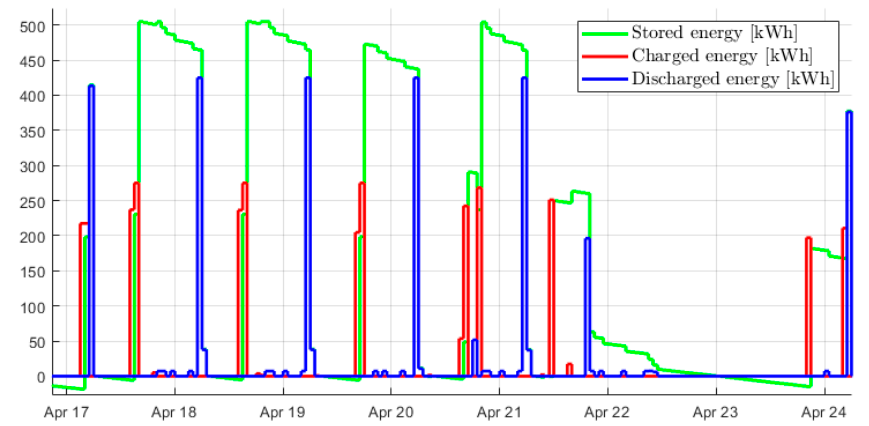
Figure 10. Optimal operation: TES stored, charged, and discharged energy in a typical week.